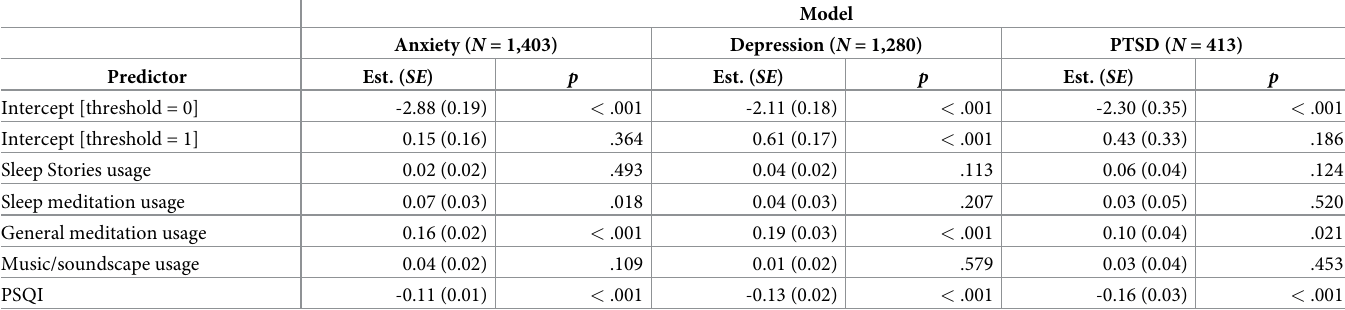
Table 11. Parameter estimates for regressions models of improvements in mental health diagnoses based on PSQI scores and frequency of using all Calm